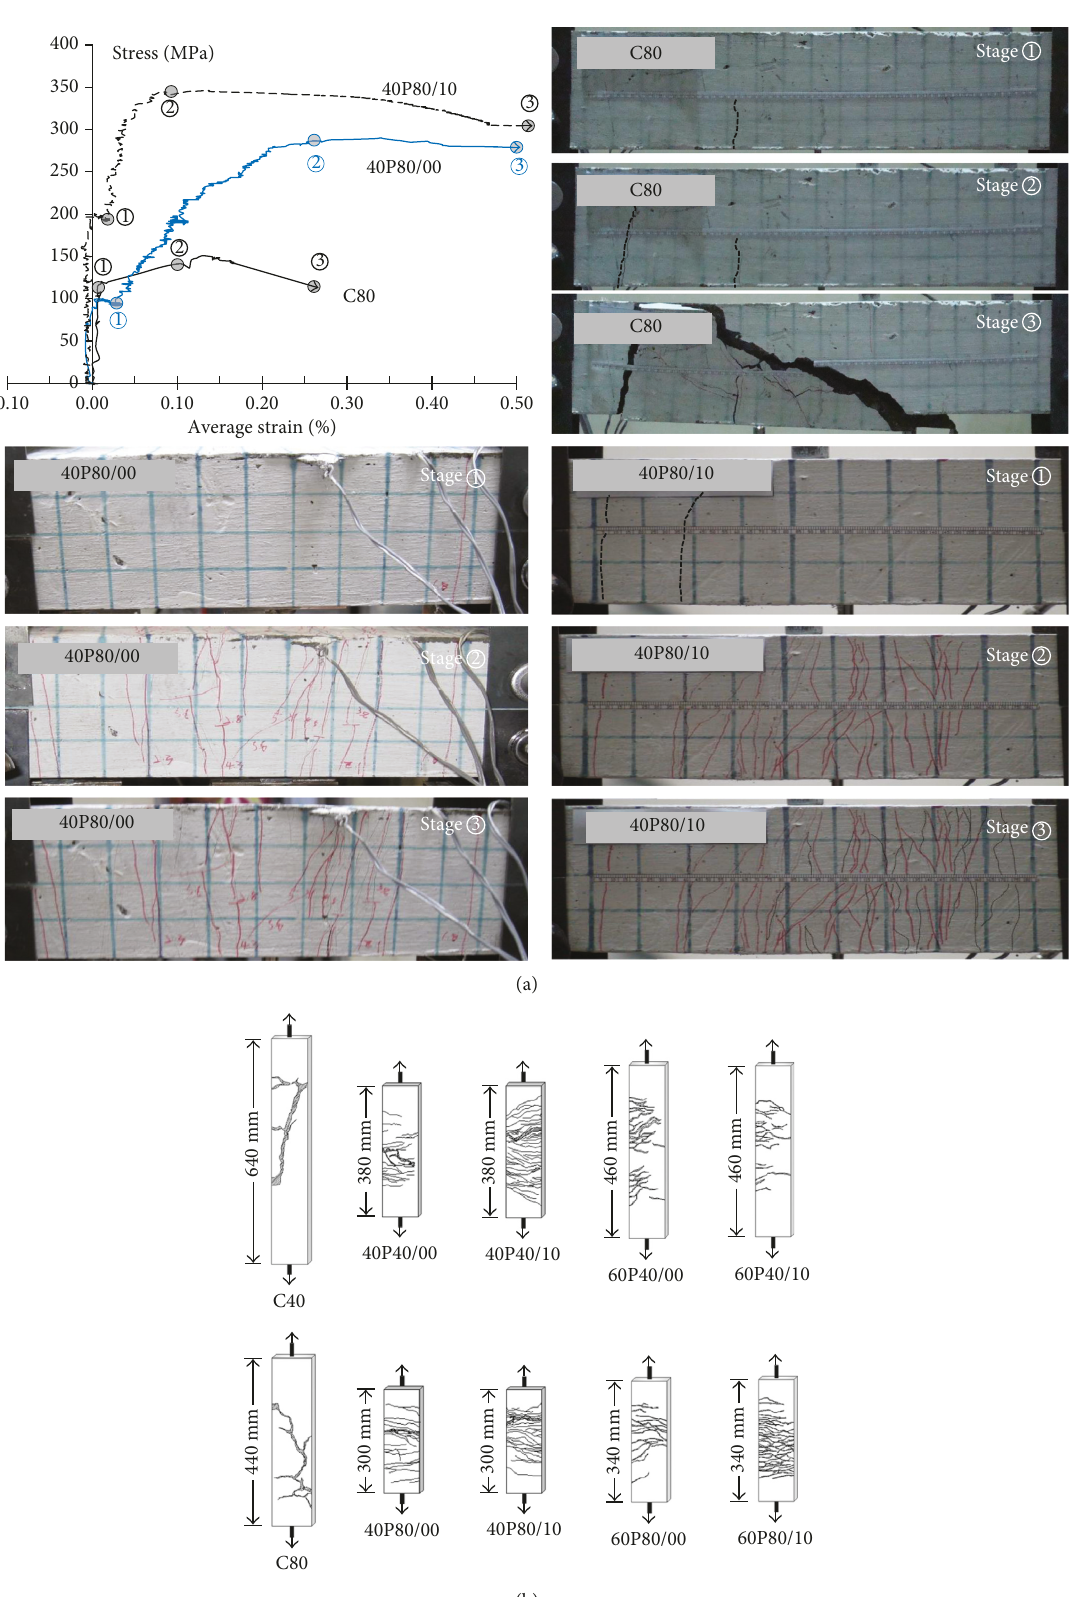
Figure 4: Typical cracking patterns of spliced specimens. (a) Typical crack propagation. (b) Cracking patterns at